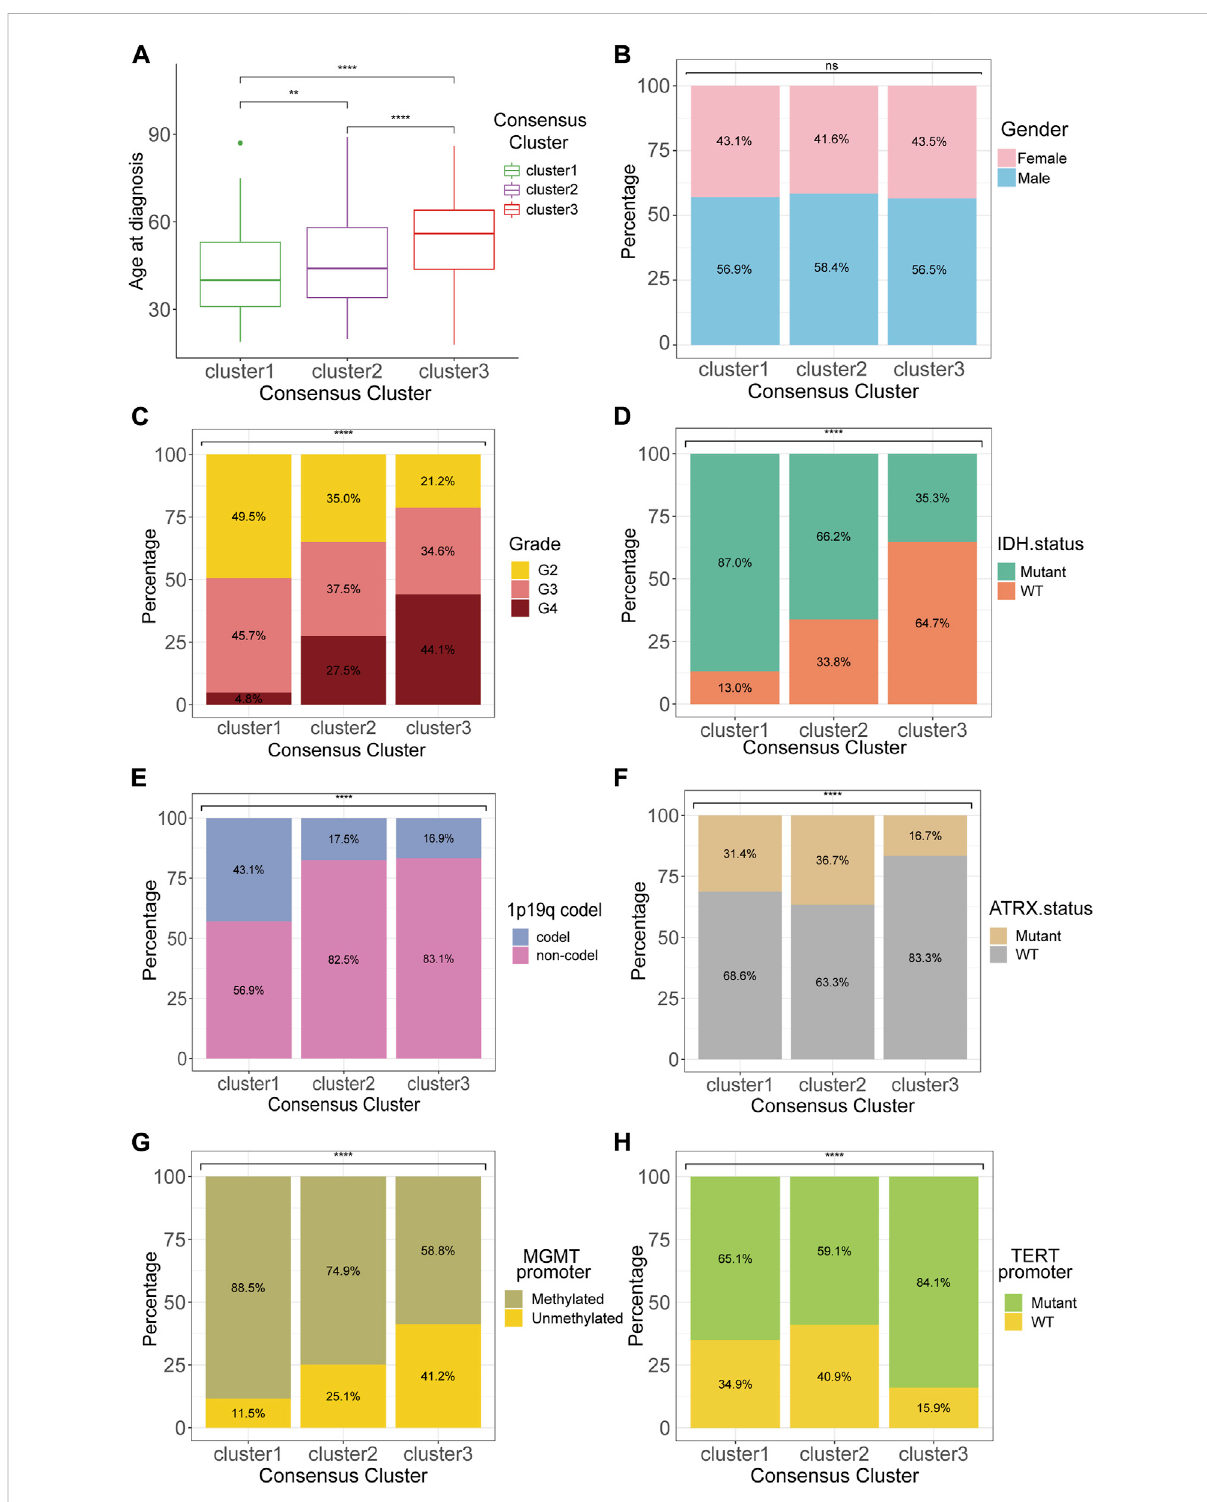
FIGURE 2 Clinicopathological features of the consensus clusters. Differences between consensus clusters in (A) age at diagnosis, (B) gender, (C) WHO grade, (D) IDH status, (E) 1p19q codeletion, (F) ATRXstatus, (G) MGMTpromotermethylation, and (H) TERTpromotermutation.* p < 0.05;** p < 0.01; *** p < 0.001; **** p <